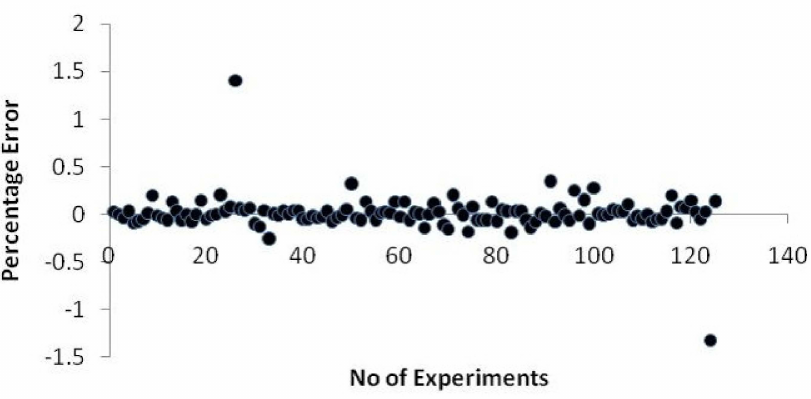
Figure 20. Error graph of network 4-8-3 for angular distortion with time gap between three passes.